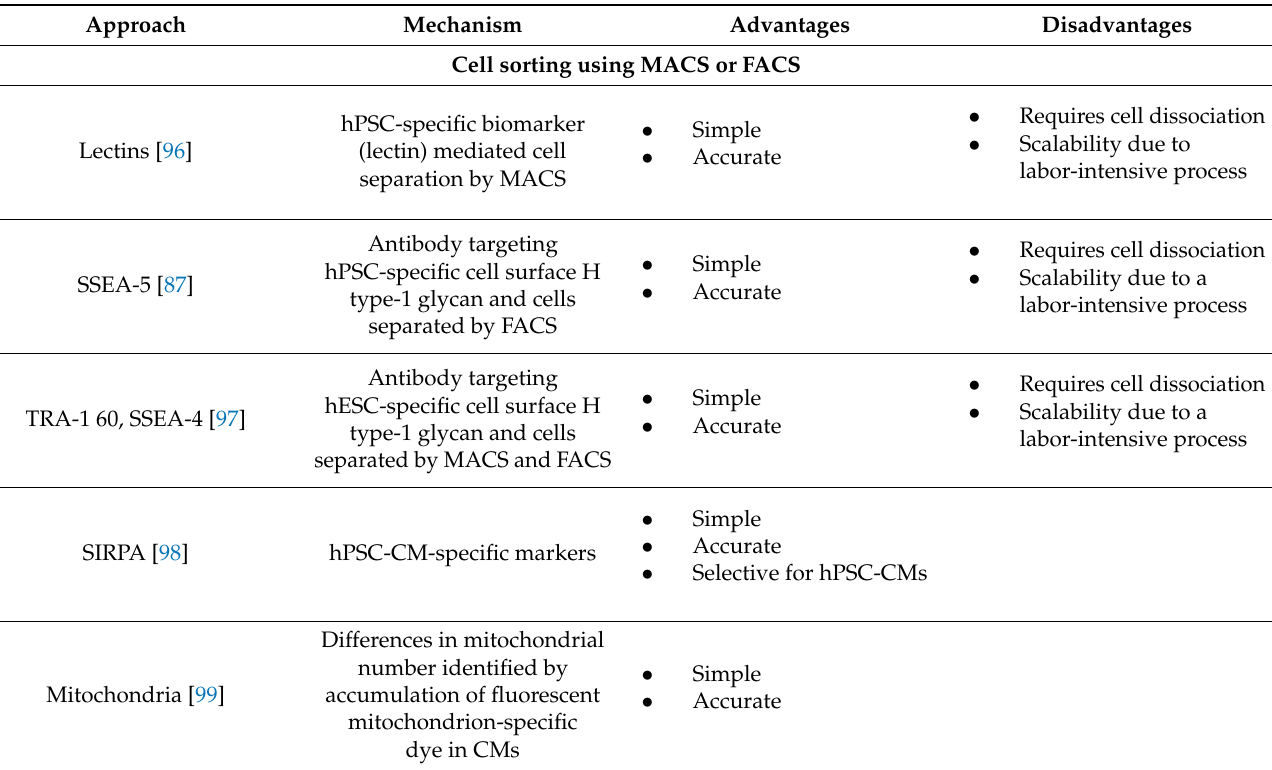
Table 2. Approaches for purifying cardiomyocyte cultures (adapted from Soma et al. [88]).